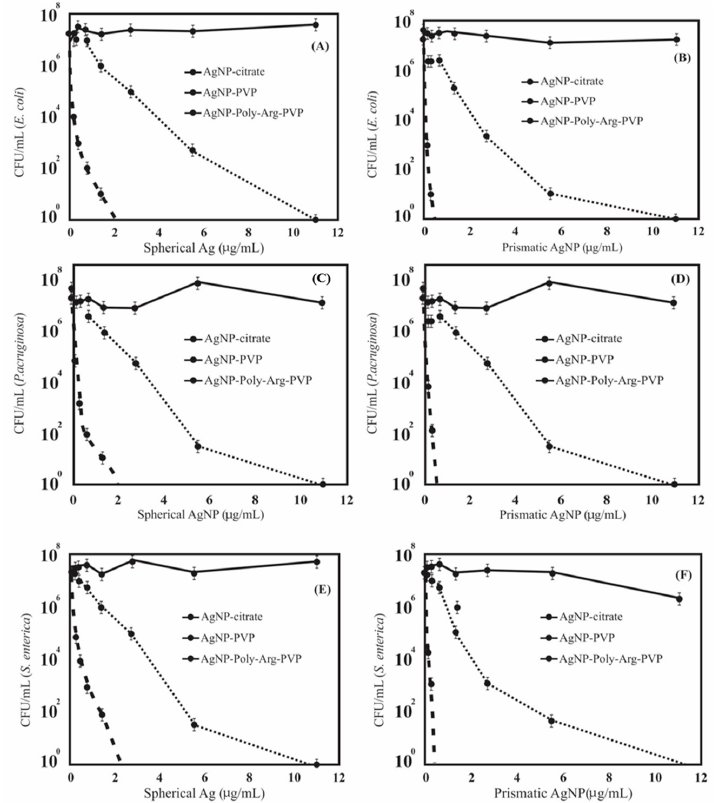
Figure 10. Shape dependent antimicrobial activity of silver nanoparticles coated with citrate, PVP and poly-Arg-PVP against E. coli ( A , B ), P. aeruginosa ( C , D ) and S. enterica ( E , F